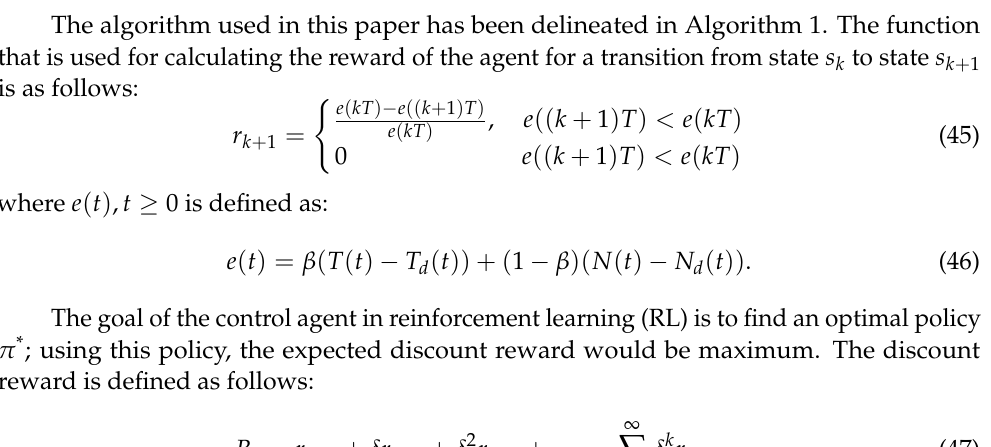
Figure 2. Structure of reinforcement learning.